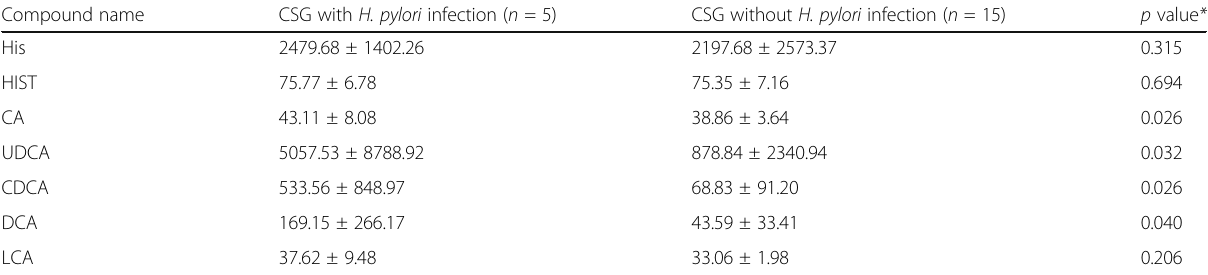
Table 3 Concentrations of HIST, His, and 5 BAs in gastric fluid of patients with CSG with or without H. pylori infection Compound